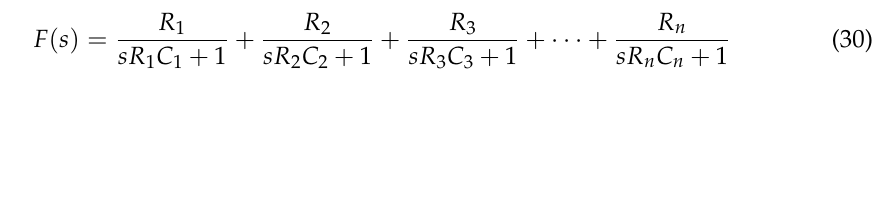
Figure 12. ( a ) Chaos attractor on the v 3 − v 4 plane. ( b ) Period attractor on the v 3 – v 4 plane. ( c ) Time series of v 3 with t (300, 500); ( d ) Time series of v 3 with t (1300, 1500).